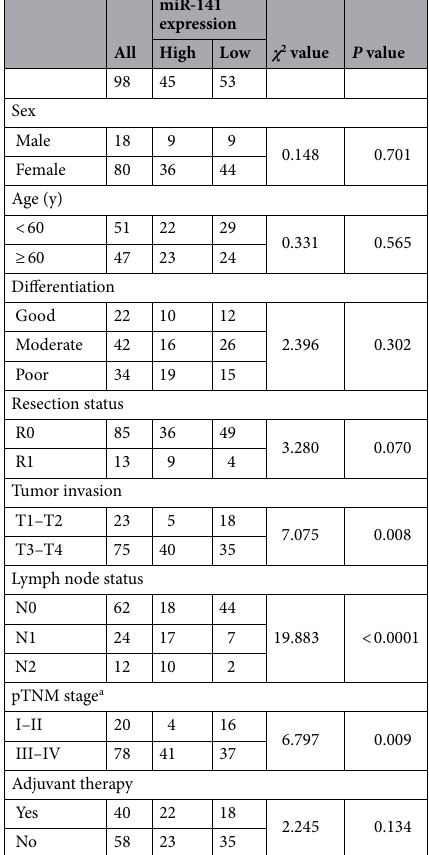
Table 1. Associations between plasma miR-141 expression and the clinicopathological characteristics in patients with GBC. a The clinicopathologic staging was performed according to the eighth edition of the criteria established by the International Union Against Cancer (UICC) in 2017. pTNM pathological tumor/node/ metastasis. GBC gallbladder